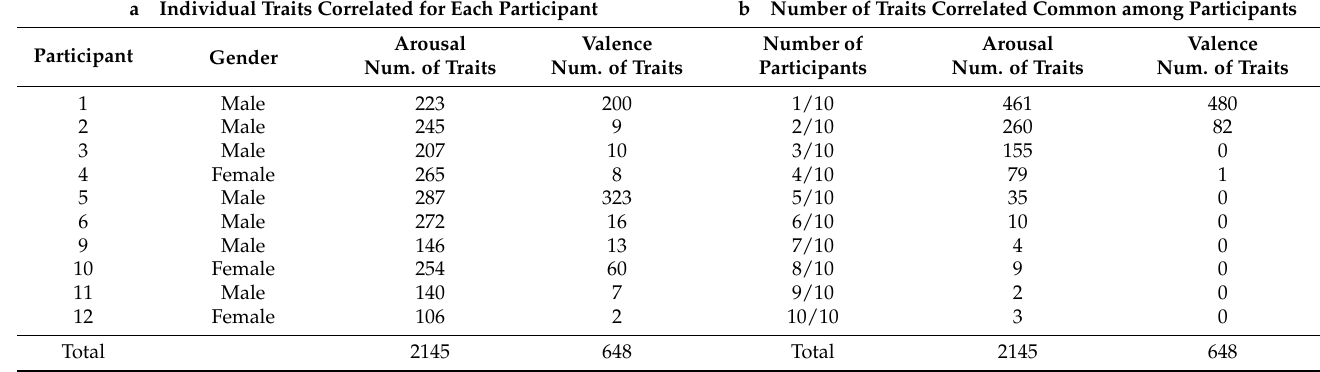
Table 4. Number of electroencephalography (EEG) traits correlated with arousal and valence score: ( a ) for each participant, ( b ) traits common among participants. a Individual Traits Correlated for Each Participant b Number of Traits Correlated Common among